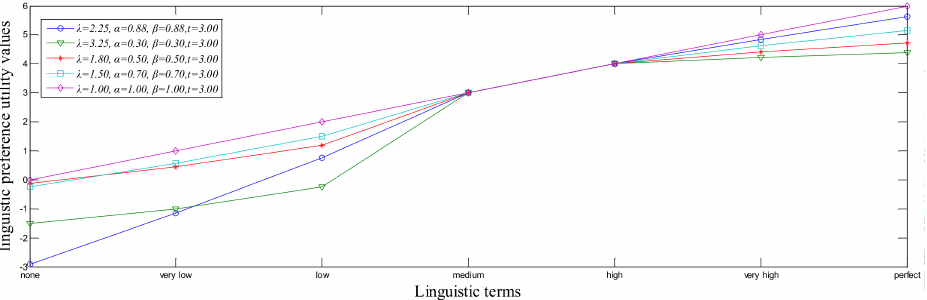
Figure 2. A set of seven linguistic terms with their linguistic preference utility